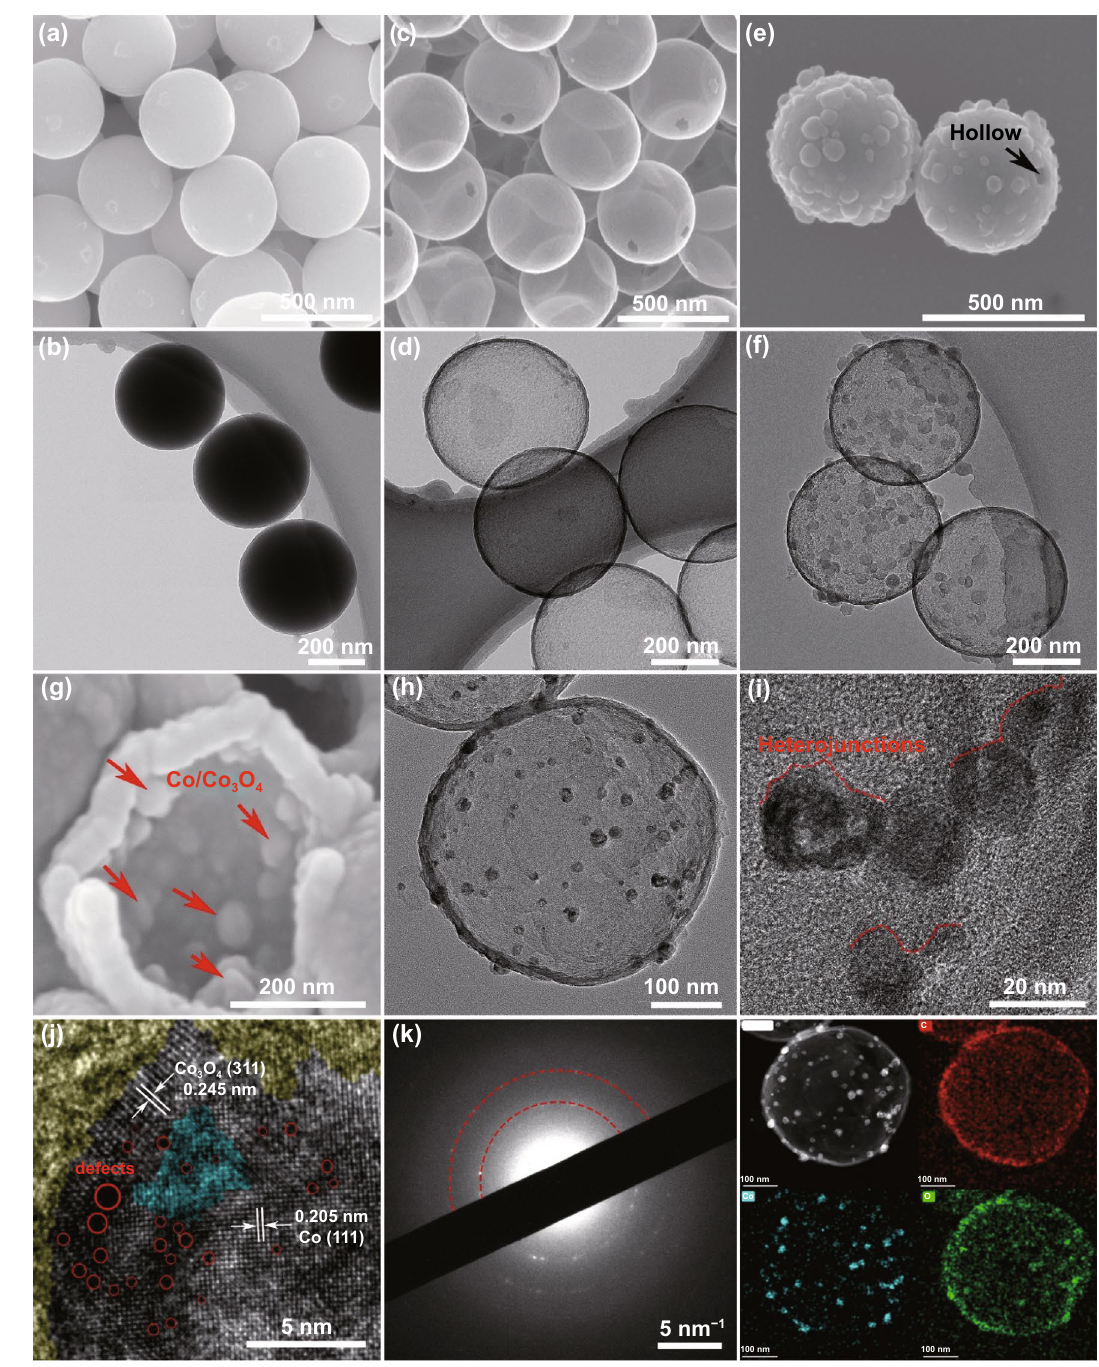
Fig. 2 SEM images and TEM images of a‑b SiO 2 @RF, c–d HCNs , e–f ZIF-67@HCNs. g–k SEM image, TEM images, HRTEM image, SAED pattern, and corresponded elemental mapping images of Co/Co 3 O 4